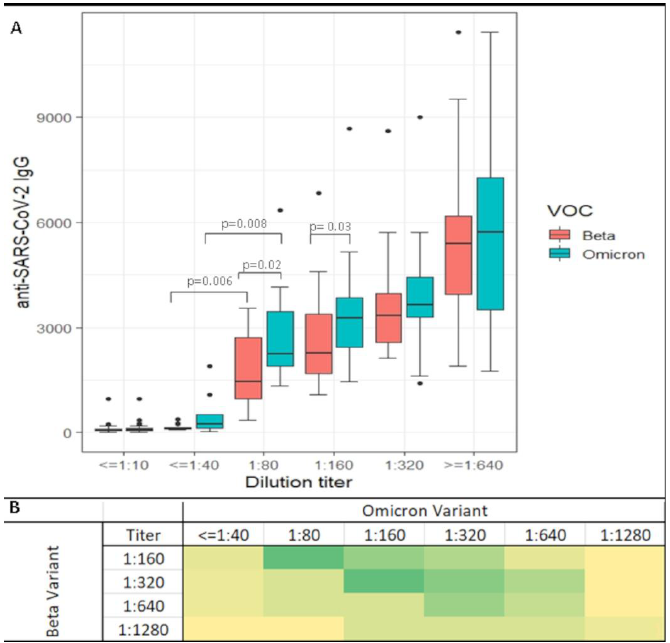
Figure 2. Box-and-whiskers plot of anti-SARS-CoV-2 IgG receptor-binding domain (RBD) levels at different neutralization. Dilution titers before and after Comirnaty vaccine third dose administration. Box plots indicate the median and interquartile range (IQR); the whiskers represent 1.5 times the IQR. Significant p -values are indicated over the brackets. Colors are related to the analyzed VOC as depicted in the picture legend (Panel ( A )). Titer distribution comparison of Beta and Omicron VOCs after the third dose. Color intensity shading from light yellow to green reflects the number of subjects associated with the different variant dilution titers (panel ( B )). Table 2. Variant-related comparison of Receiver-Operating Characteristics (ROC) curves for anti- SARS-CoV-2 IgG receptor-binding domain (RBD) values (BAU/mL) and neutralizing antibody percent inhibition rate (Nab%) at 1:80 neutralization dilution titer in vaccinated subjects. The area under the curve (AUC), fitting p-value and calculated specificity and sensitivity are included in the picture. The optimal cutoff point (Youden Threshold) was defined as the minimum value of (1-sensitivity) 2 + (1-specificity) 2 . Chosen thresholds are referred to as